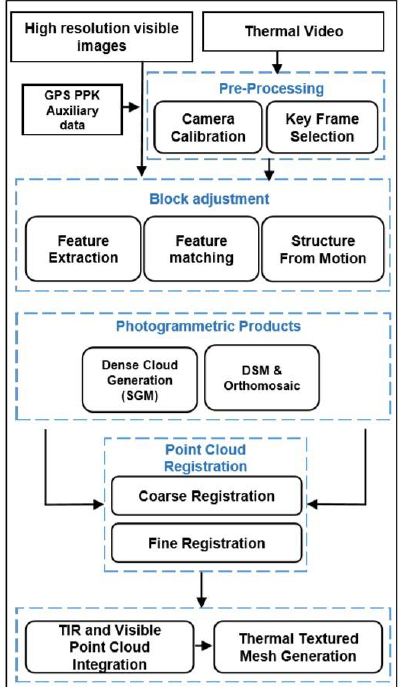
Figure1. Diagram of the proposed